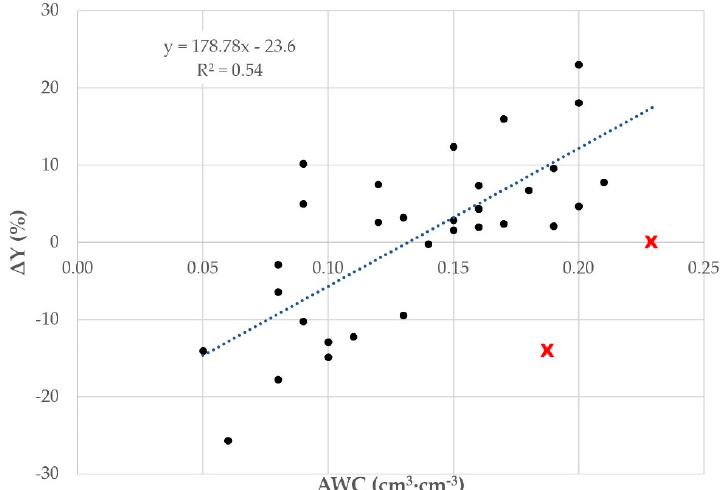
Figure 8. Linear regression between the mean yield variation ( ∆ Y) and soil available water capacity (AWC). The X symbols represent the two outliers removed from the calculation of linear regression (more details in the text).